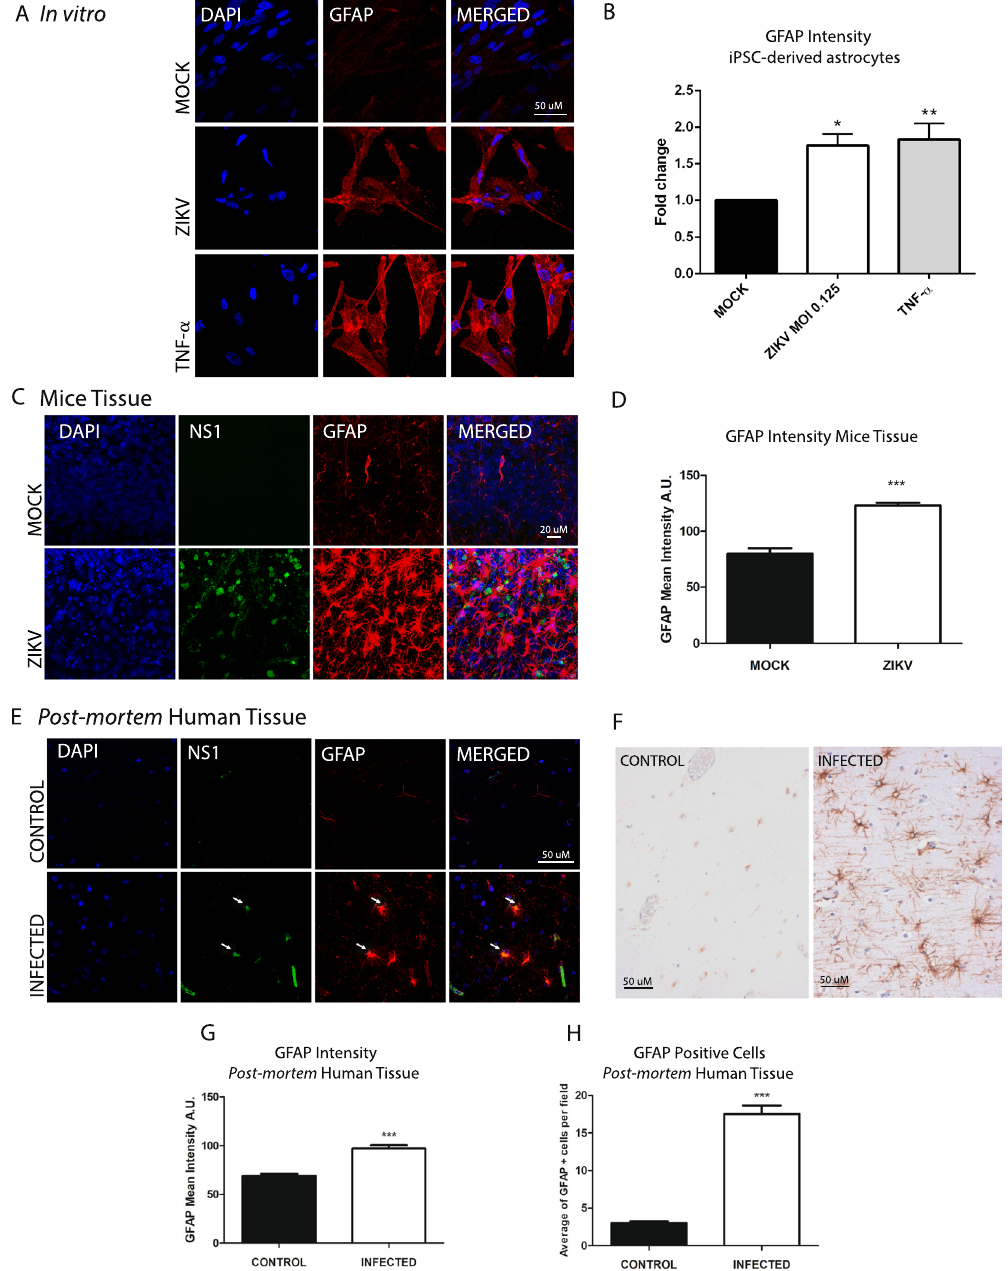
Figure 6. Astrogliosis induced by ZIKV infection. ( A ) Immunofluorescence images of MOCK-, ZIKV-infected iPSC-derived astrocytes and TNF- α condition as positive control. DAPI (blue) and GFAP (red). Scale bar: 50 μ m. ( B ) Quantification of GFAP intensity in MOCK- and ZIKV-infected astrocytes at 4 dpi, MOI = 0.125. Quantification of TNF- α (10 ng/ml) condition as positive control of gliosis assay. N = 4. * p = 0.015, ** p = 0.0085. ( C ) Immunofluorescence images of ZIKV-infected mice brains. DAPI (blue), ZIKV NS1 protein (green) and GFAP (red). Scale bar: 20 µ m. ( D ) Quantification of GFAP intensity in MOCK- and ZIKV-infected 7 dpi mice cingulate cortex. N = 3. ( E ) Immunofluorescence images of control and infected post-mortem human brains. DAPI (blue), ZIKV NS1 protein (green) and GFAP (red). White arrows indicate GFAP positive infected cells. Scale bar: 50 µ m. ( F ) Immunohistochemistry for GFAP in control and infected post-mortem human brains. ( G,H ) Quantification of GFAP intensity and average number of GFAP positive cells in post-mortem human tissue, respectively. Data is shown as average ± SEM; *** p <